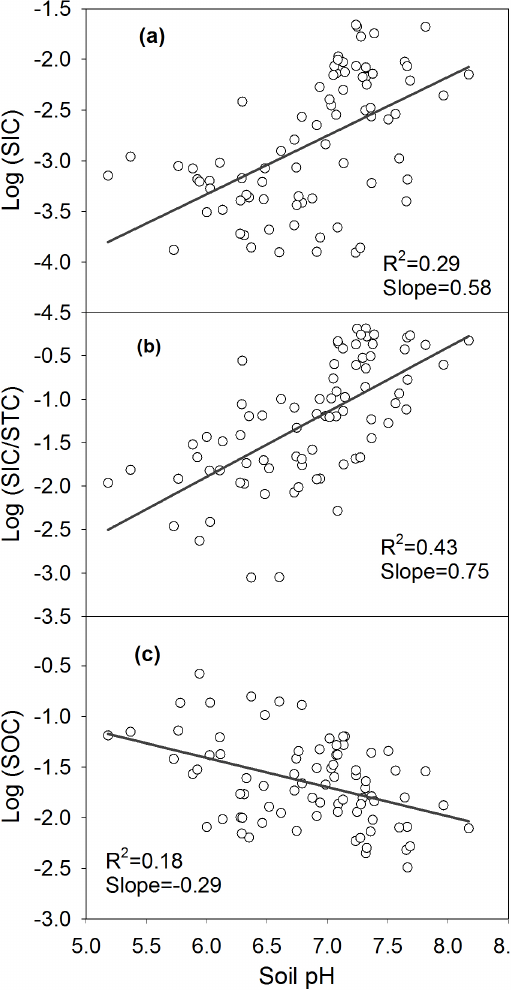
Fig. 4. Linear relationships of SIC (a) , SIC/STC (b) and SOC (c) with soil pH value in the topsoil. All regression lines were sig- nificant ( P < 0 .